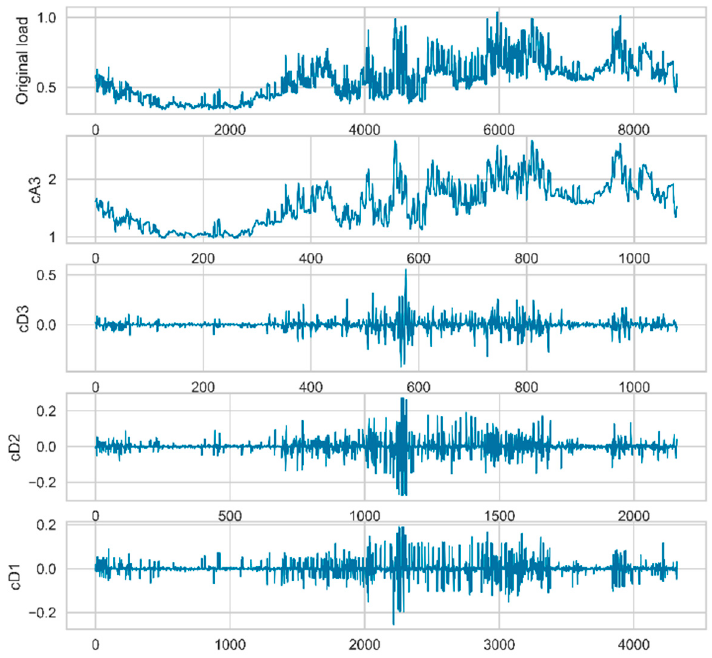
Figure 5. The curves of the components using the db4 wavelet.